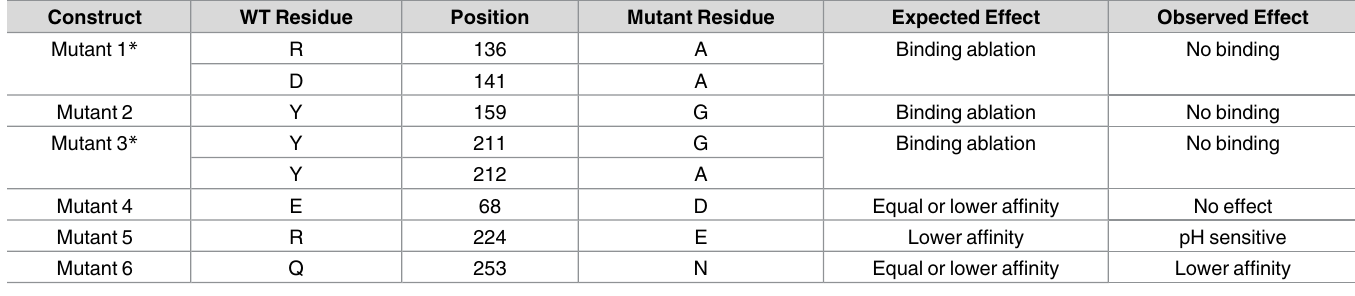
MBP peptides, peptides identified in Table 1 for the LbpB N-lobe:hLf C-lobe interaction and